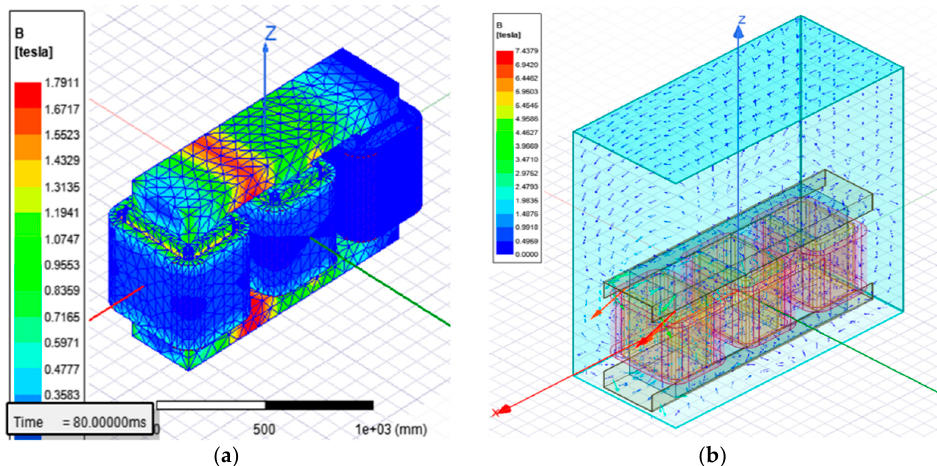
Figure 6. Flux density simulations of standard design transformer: ( a ) core; ( b ) tank.